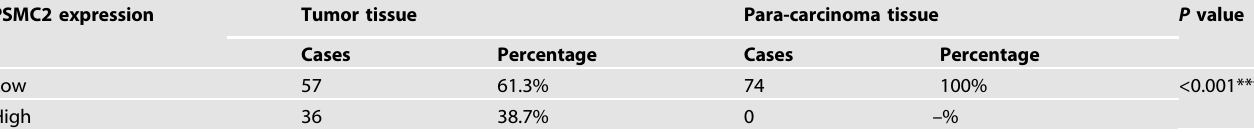
Table 1. Expression patterns in gastric cancer tissues and para-carcinoma tissues revealed in immunohistochemistry analysis. PSMC2